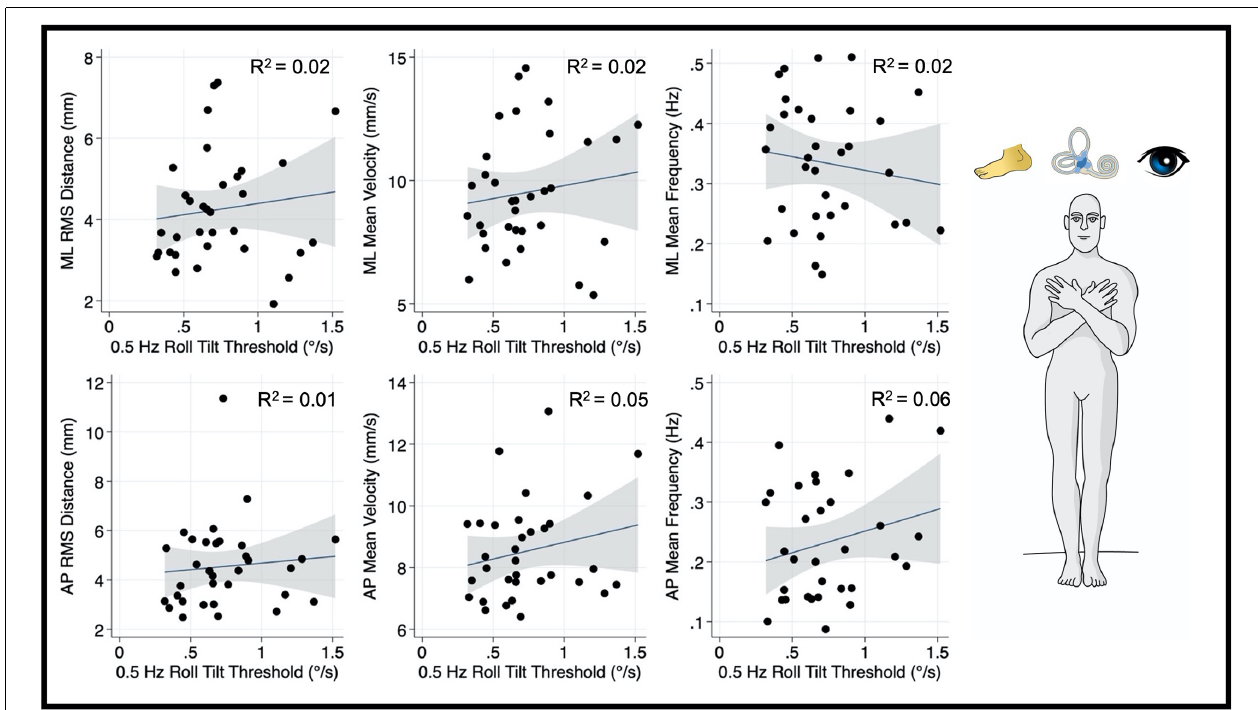
FIGURE 6 | Relationship between 0.5 Hz roll tilt thresholds and RMSD, mean velocity, and mean frequency for both the mediolateral plane (top) and anteroposterior plane (bottom) during an “eyes open, firm” balance task. To the right of the plots, the task and relevant balance control systems are displayed, showing the presence of proprioceptive and visual, as well as vestibular, cues in the “eyes open, firm” condition. Each data point represents one individual’s performance. The blue line shows a linear fit with the 95% CI depicted by the gray shaded region. Unlike the “eyes closed, foam” condition, no significant linear effects were observed between RMSD, MV, or MF and 0.5 Hz roll tilt thresholds. MF, mean frequency; MV, mean velocity; RMSD, root mean square distance.